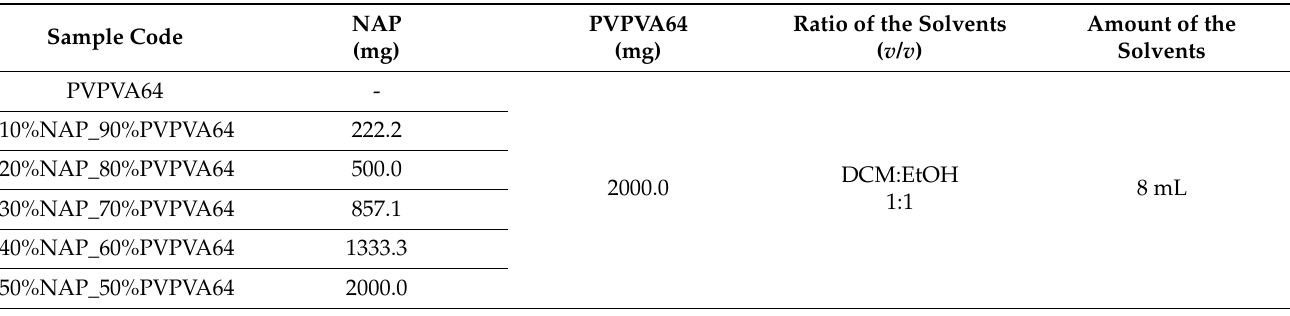
Table 1. Summary of the prepared NAP-PVPVA64 compositions.